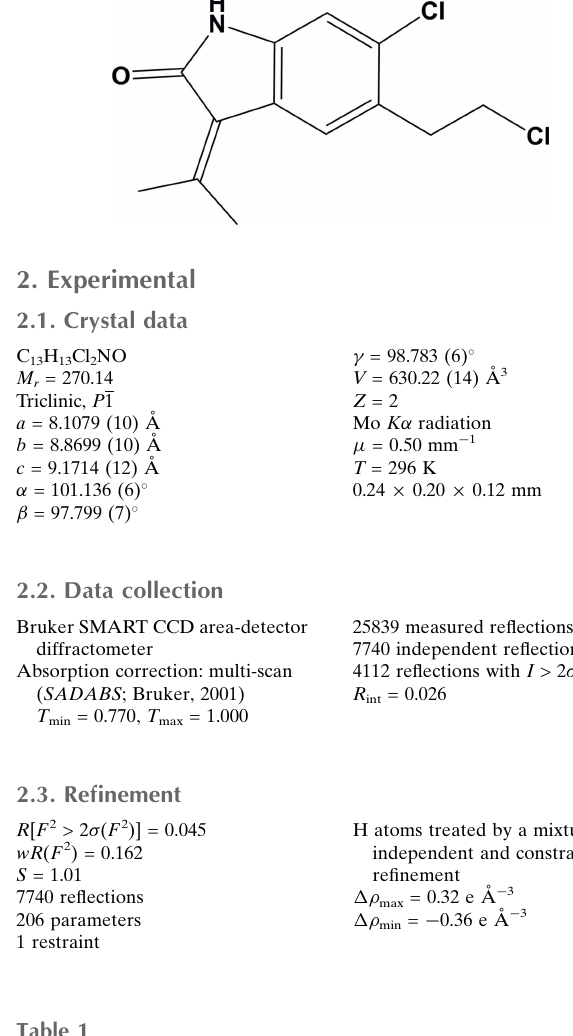
Hydrogen-bond geometry (A˚ , (cid:3)